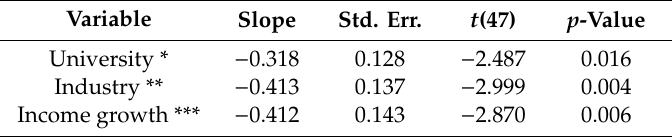
Table 4. Forward step-wise multiple regression with the gender gap (years) in the mean age at marriage (2017) as dependent variable and contextual indicators as predictors (Adjusted R 2 = 0.274; F (3,47) = 7.28; p < 0.0004; Std. Error of estimate = 0.85). Variable Slope Std. Err. t (47) p -Value University * − 0.318